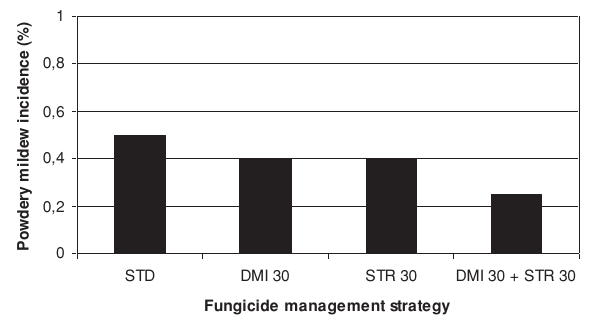
Figure 3. Effi cacy of DMI and strobilurin spray programmes (STD = Standard, DMI 30 = DMI dominant, STR 30 = strobilurin dominant, DMI 30 + STR 30 = DMI and strobilurin dominant) on powdery mildew incidence on shoot of cultivar Jonagold in 2010 at Mándok (LSD